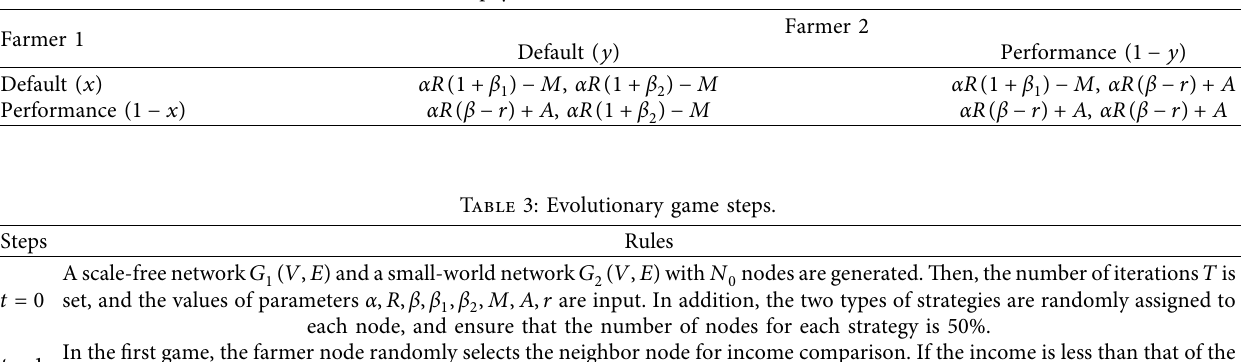
Table 2: Game payoff matrix between farmer 1 and farmer 2.